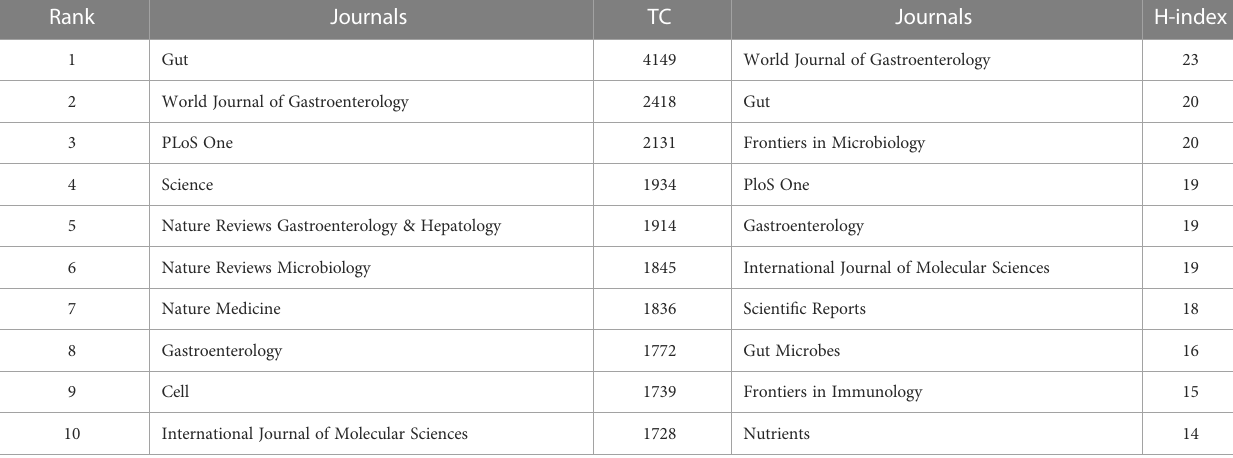
TABLE 2 The top 10 local impact journals in